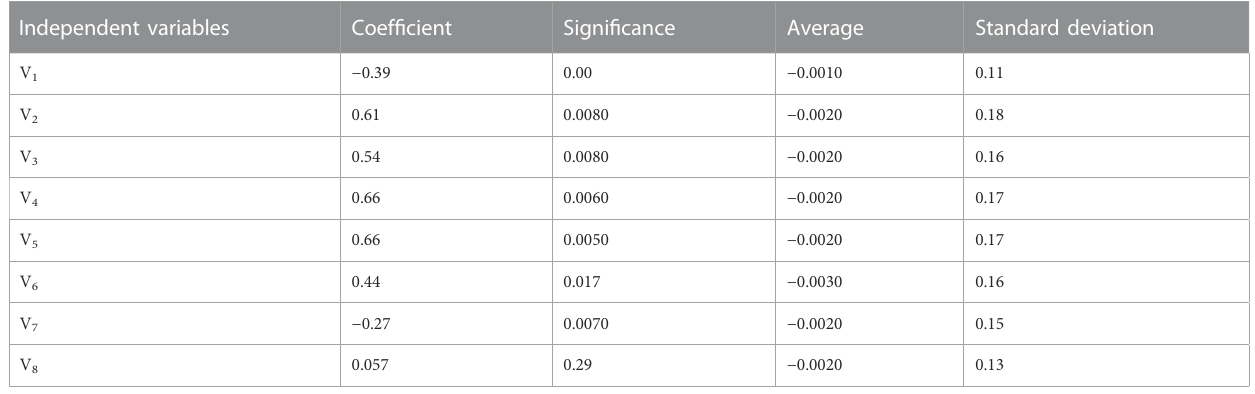
TABLE 2 Coef fi cient between PM 2.5 spatial association and potential driving factors by QAP correlation analysis. Independent variables